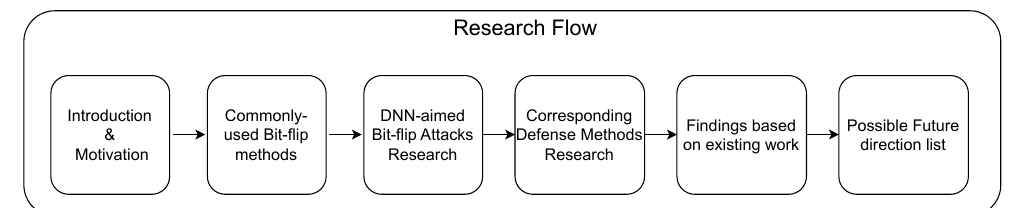
Figure 2. Research flow of this